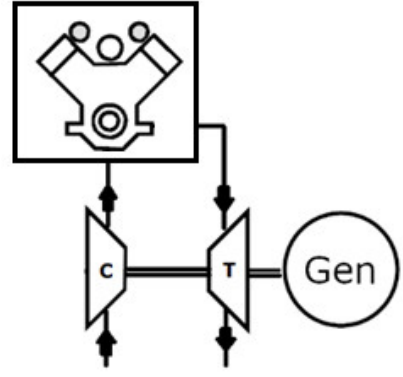
Figure 34. Turbocompound power unit scheme.